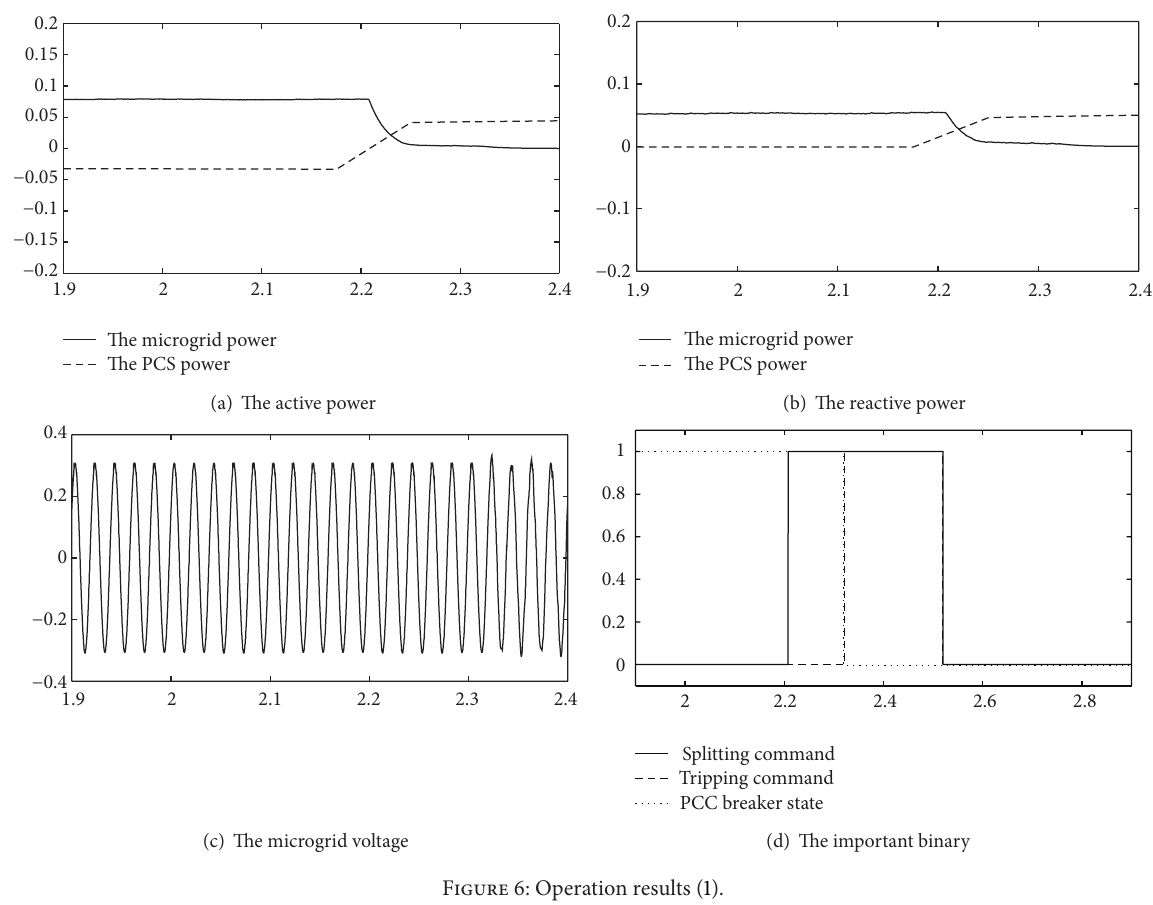
Figure 6: Operation results